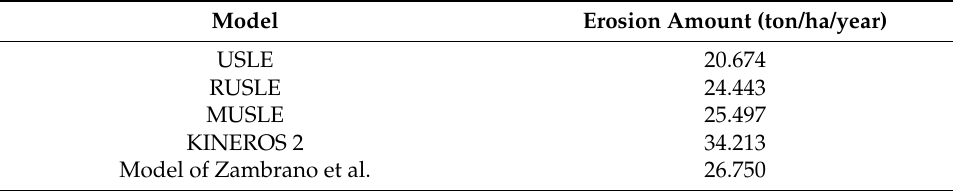
Table 6. Differences between calculated erosion amounts for each method (including Event 7)